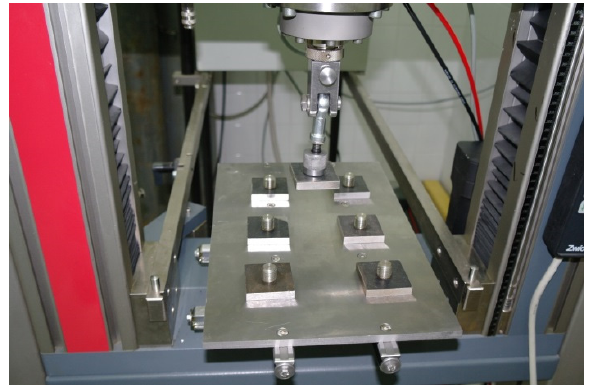
Figure 1. Coating adhesion strength test stand.